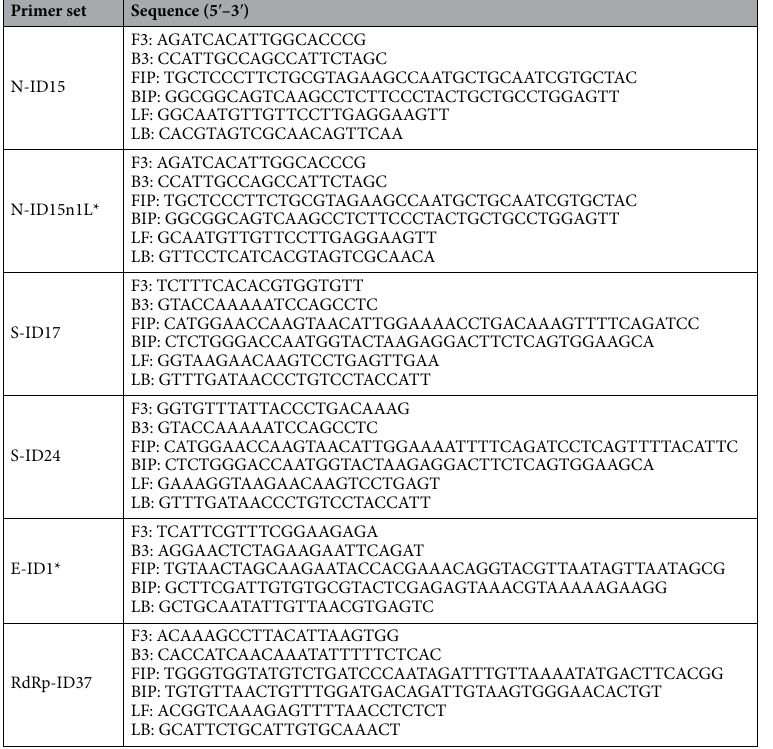
Table 1. Sequences of each RT-LAMP primer set used in this study. F3, forward outer; FIP, forward inner; LF, loop forward; B3, backward outer; BIP, backward inner; LB, loop backward. All the primers were designed by using the PrimerExplorer program. *Jamwal et al. 27 designed and used these primer